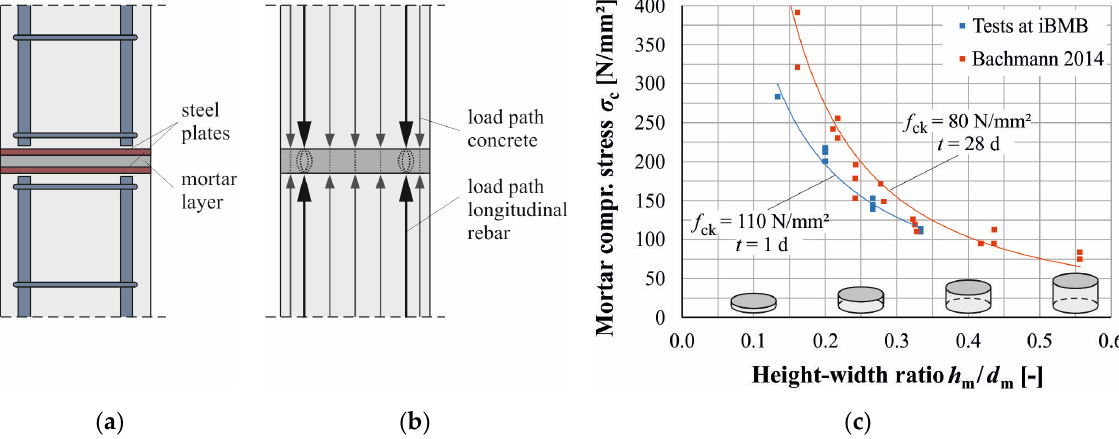
Figure 2. ( a ) Butt joint with steel plates; ( b ) model for force transmission according to [20]; ( c ) mortar compressive strength depending on height–width ratio [6].